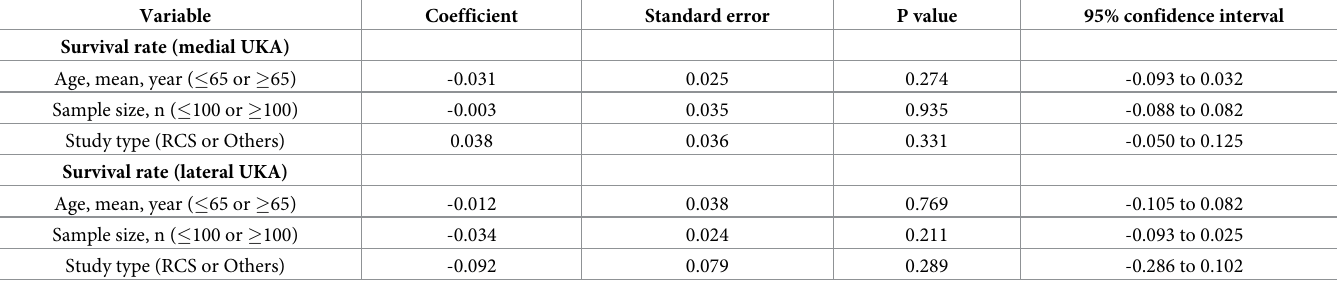
Table 3. Meta-regression analyses of potential sources and difference in survival rate for medial or lateral UKA. Variable Coefficient Standard